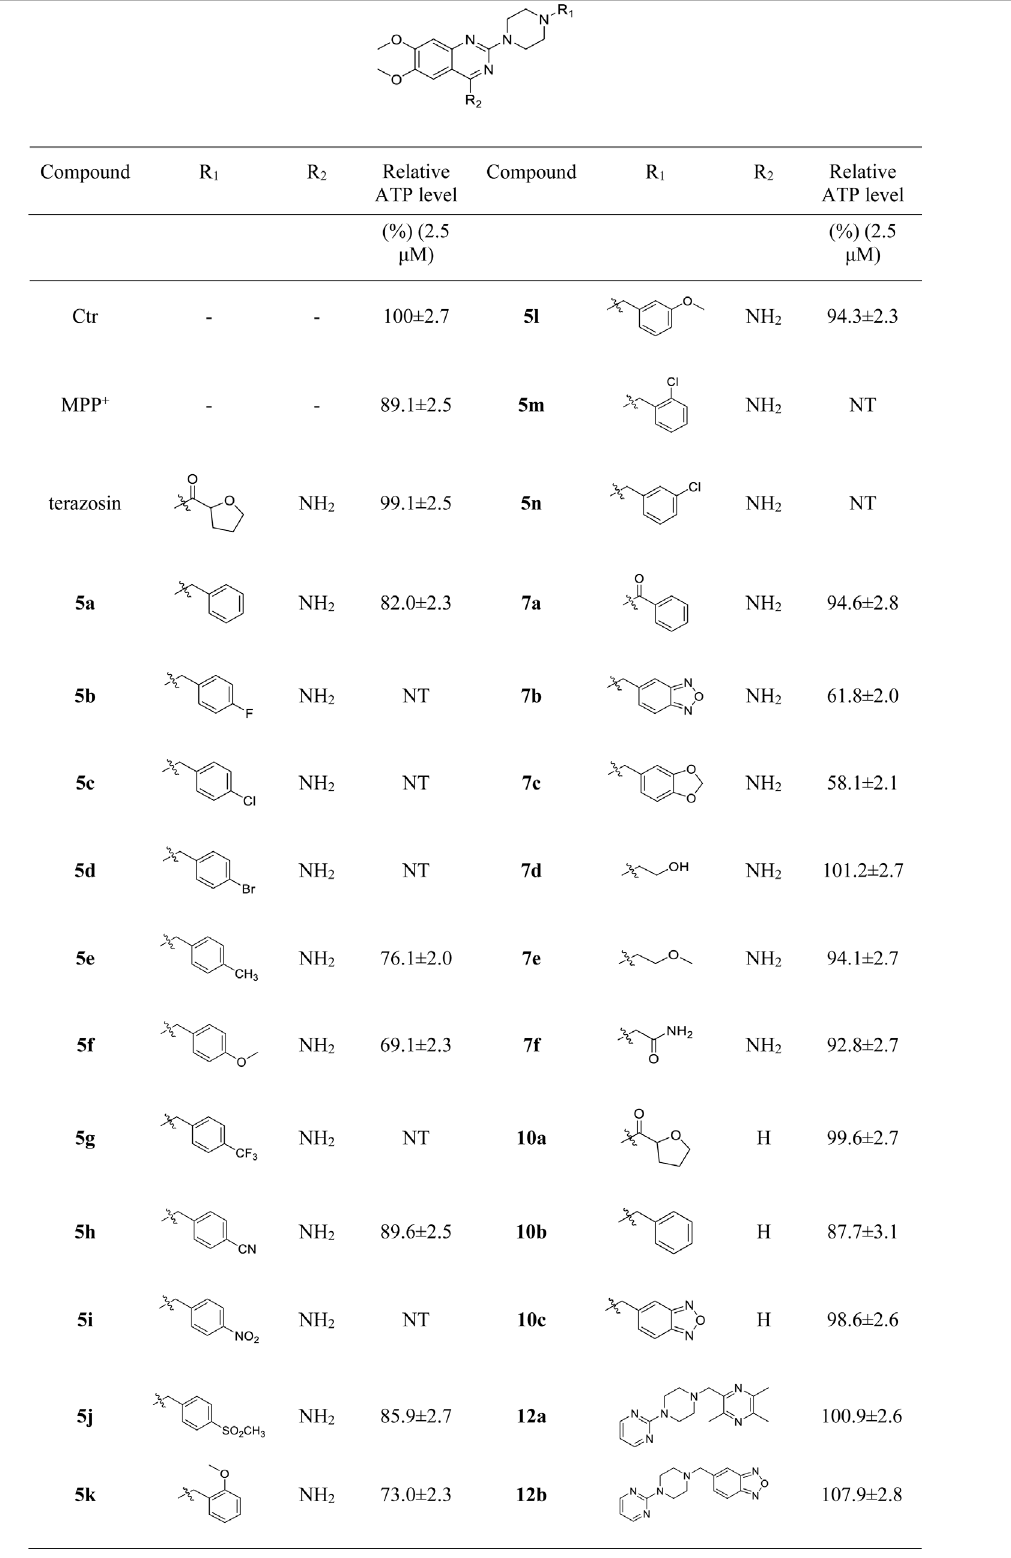
Frontiers in Chemistry |